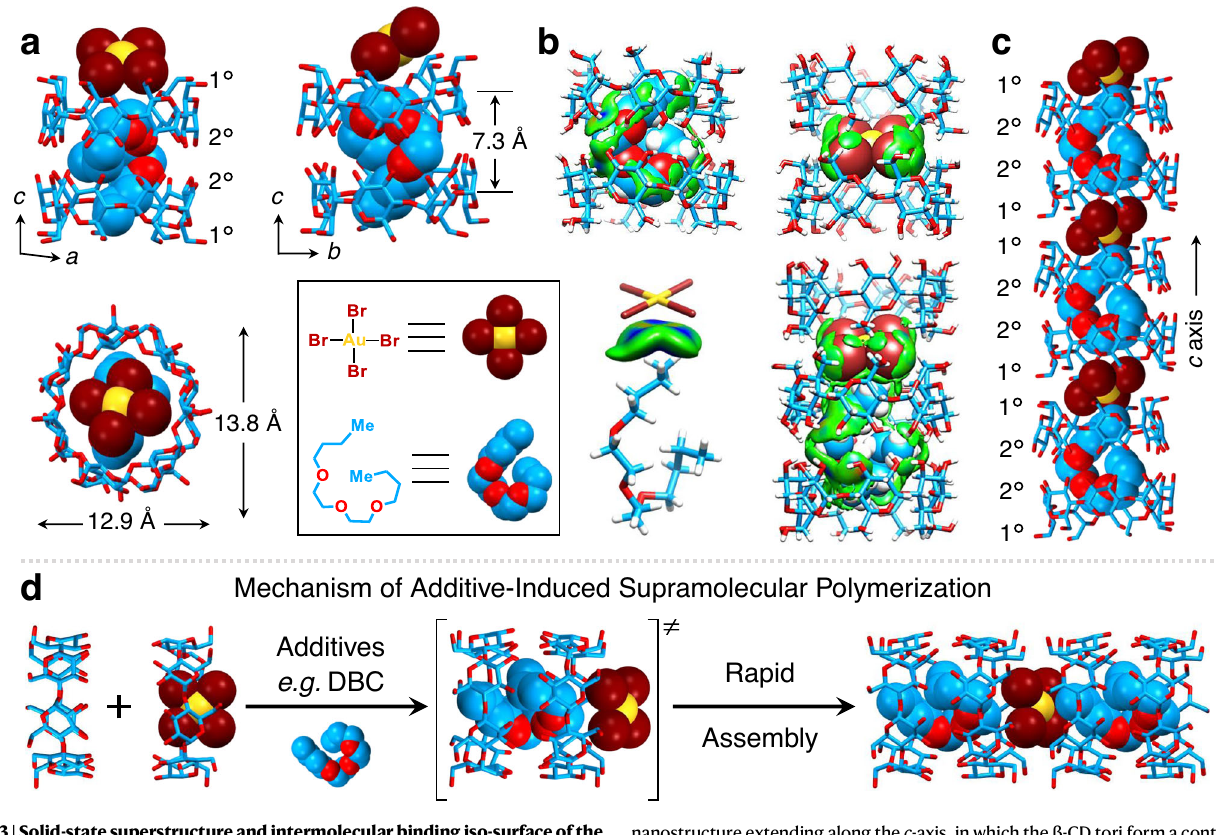
nanostructureextendingalongthe c -axis,inwhichthe β -CDtoriformacontinuous channel occupied by alternating DBC and [AuBr 4 ] − anions. Solvent molecules have been omitted for the sake of clarity. The “ 1° ” represents the primary face and the “ 2° ” representsthesecondaryfaceof β -CD.Hwhite,Cskyblue,Ored,Brbrown,Au yellow. d Schematic illustration of the mechanism of additive-induced supramo- lecular polymerization after adding various additives to the solution of β -CD and [AuBr 4 ] −